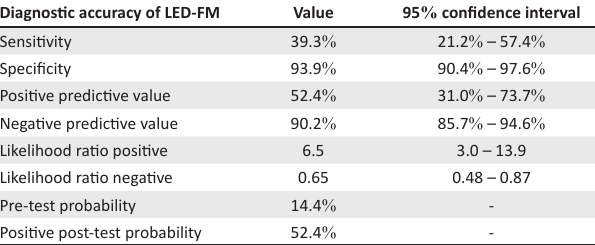
TABLE 2: Diagnostic performance of light-emitting diode fluorescence microscopy compared to reference standard (culture), Ethiopia, 2014. Diagnostic accuracy of LED-FM